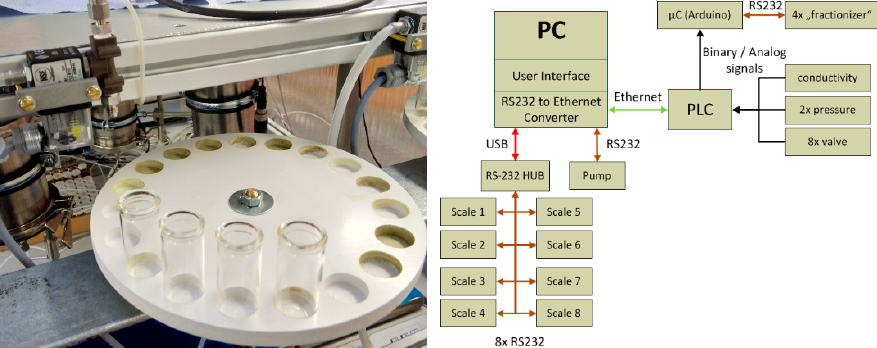
Figure 9. Automated sampling reel for sample collection.